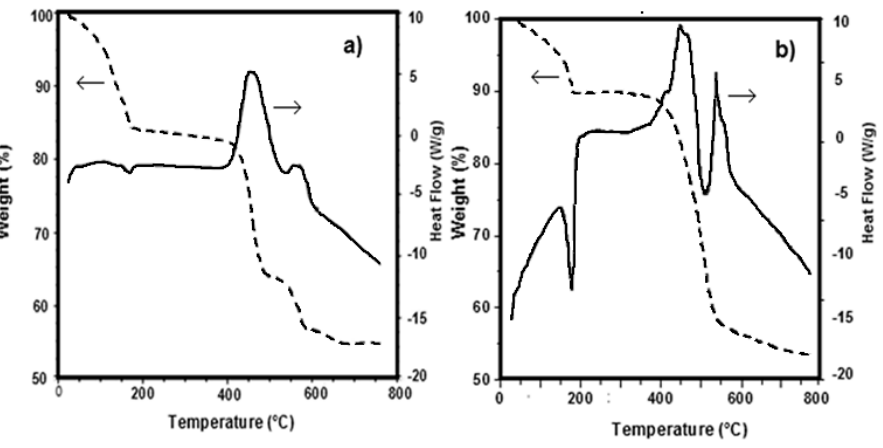
Figure 3. DSC ‐ TG curves of: ( a ) sample S1 : P1/ Li 2 CO 3 ; and ( b ) sample S2 : ( P2 : P3 = 0.9:0.1)/Li 2 CO 3 .